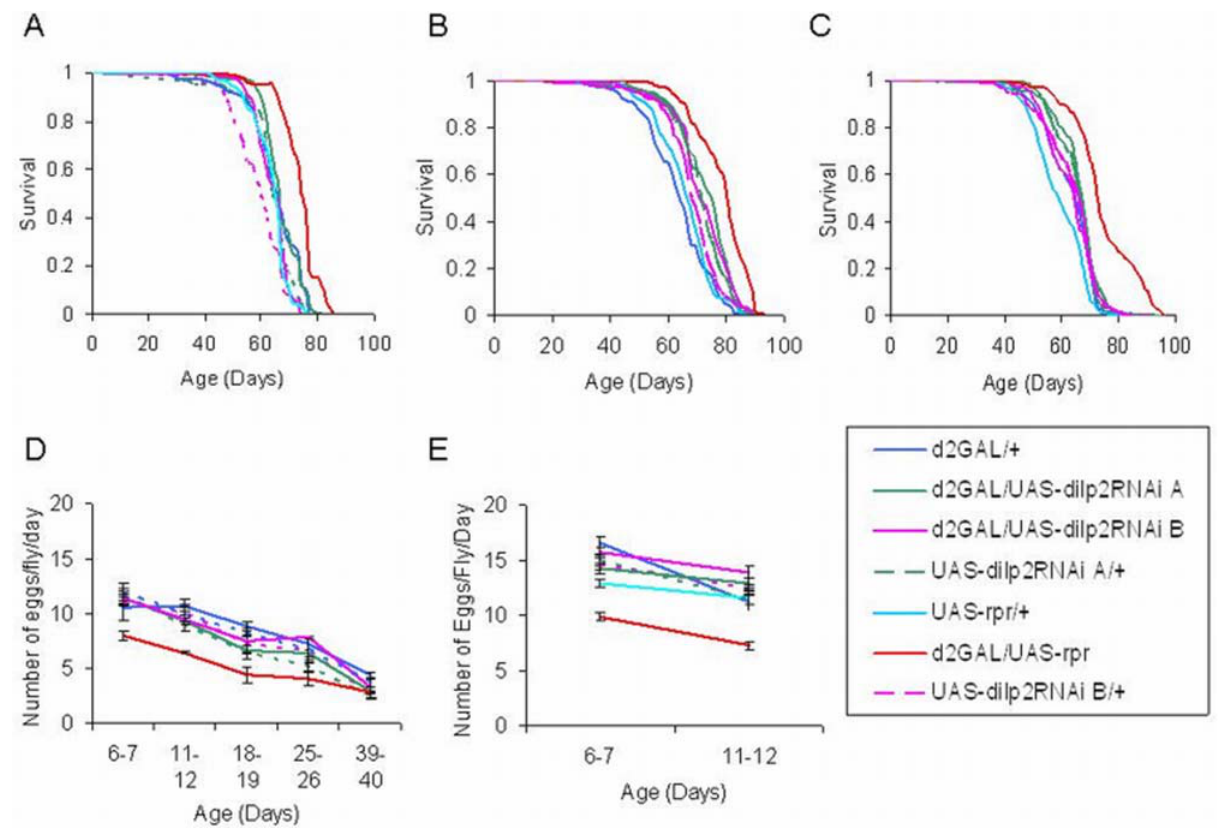
Figure 2. dilp2RNAi/d2GAL mated females are not long-lived or less fecund than controls. Survival curves, median lifespans, percentage increase compared to control, and sample sizes are as follows. (A): Experiment 1. Median lifespan of: UAS-rpr/d2GAL=75 days (13.6% increase over UAS- rpr / + & d2GAL/ + controls, P , 0.0001), N=69; UAS-dilp2RNAiA/d2GAL=67 days, N=71; UAS-dilp2RNAiA/ + =66 days, N=36; UAS-dilp2RNAiB/ d2GAL=66 days, N=130; UAS-dilp2RNAiB/ + =60 days, N=92; UAS-rpr/ + =66 days, N=110; and d2GAL/ + =66 days, N=61. (B) Experiment 2. Median lifespan of: UAS-rpr/d2GAL=81 days (19% increase over UAS- rpr / + control, P , 0.0001), N=155; UAS-dilp2RNAiA/d2GAL=76 days, N=157; UAS- dilp2RNAiA/ + =73 days, N=137; UAS-dilp2RNAiB/d2GAL=71 days, N=145; UAS-dilp2RNAiB/ + =69 days, N=129; UAS-rpr/ + =68 days, N=139; and d2GAL/ + =64 days, N=153. (C) Experiment 3. Median lifespan of: UAS-rpr/d2GAL=73 days (12% increase over d2GAL/ + control, P , 0.0001), N=153; UAS-dilp2RNAiA/d2GAL=68 days, N=180; UAS-dilp2RNAiA/ + =67 days, N=166; UAS-dilp2RNAiB/d2GAL=65 days, N=179; UAS-dilp2RNAiB/ + =67 days, N=175; UAS-rpr/ + =59 days, N=149; and d2GAL/ + =65 days, N=169. (D) Fecundity of females from experiment 1 shown in ( A ). ( E) Fecundity of females from experiment 2 shown in ( B ). Data are shown as mean number of eggs laid per female per day 6